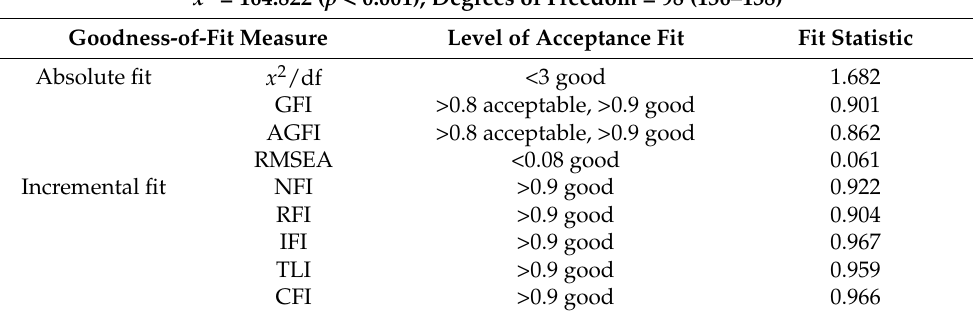
Table 3. Goodness-of-fit of the measurement model.